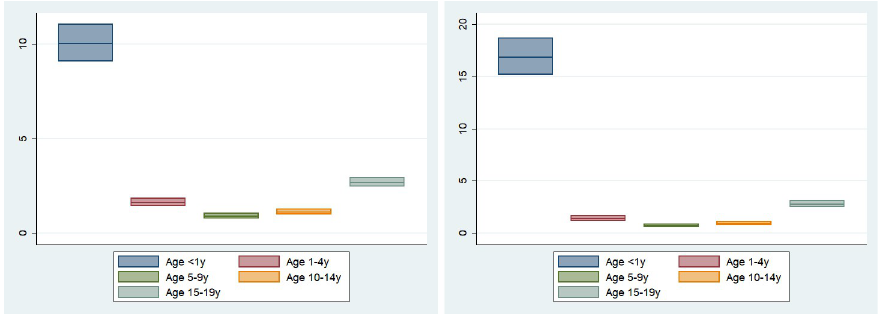
Fig 4. Age-specific deaths and ICU admissions (/1,000,000 children). A. Age-specific deaths (/1,000,000 children). B. Age-specific ICU admissions (1,000,000 children). Age-specific national data with up to one year difference of age buckets were included. For example, age-specific national data reporting outcomes of 1–5 years and 10–15 years were included in our calculation of 1–4 years and 10–14 years. Abbreviations: y, years.